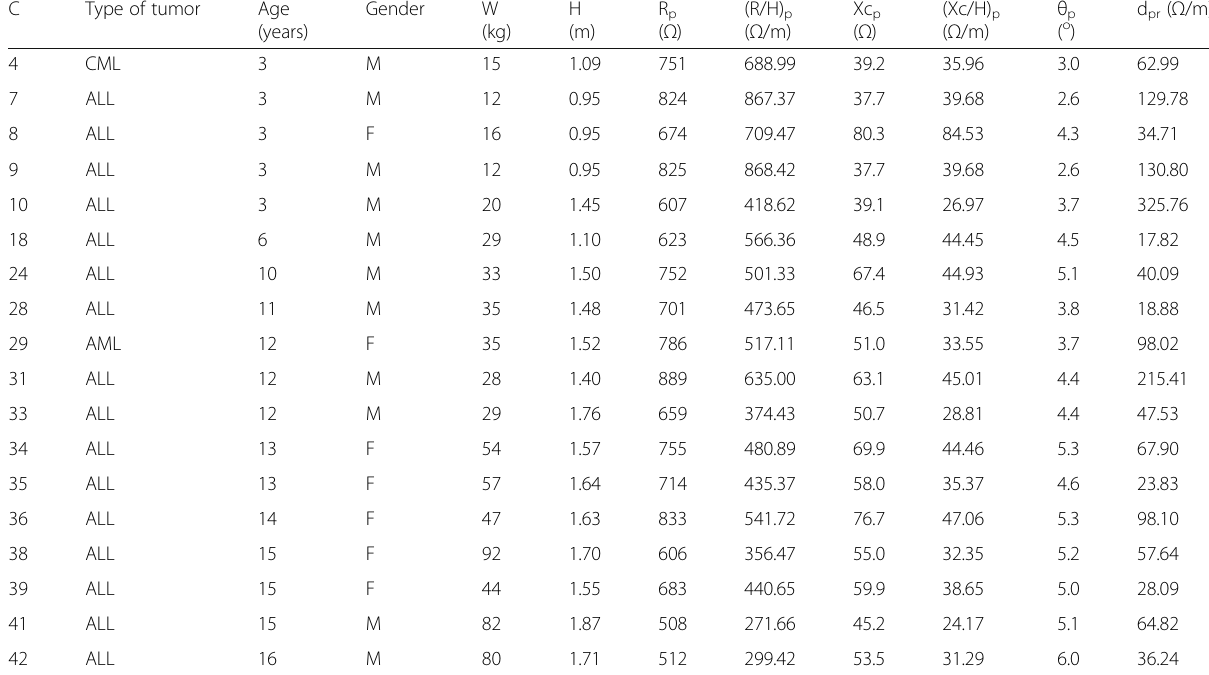
Table 3 Different variables for each patient with non-solid